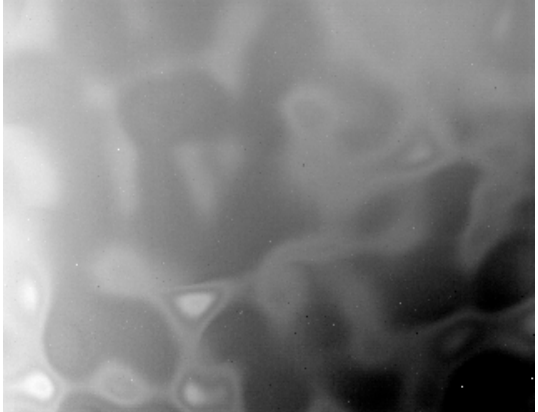
Figure 12. Corrected sky image with fixed-pattern noise. (average grayscale value of 6673DN, which is close to the − 20 °C black body temperature corrected using the coefficients in Figures 7 and 8).